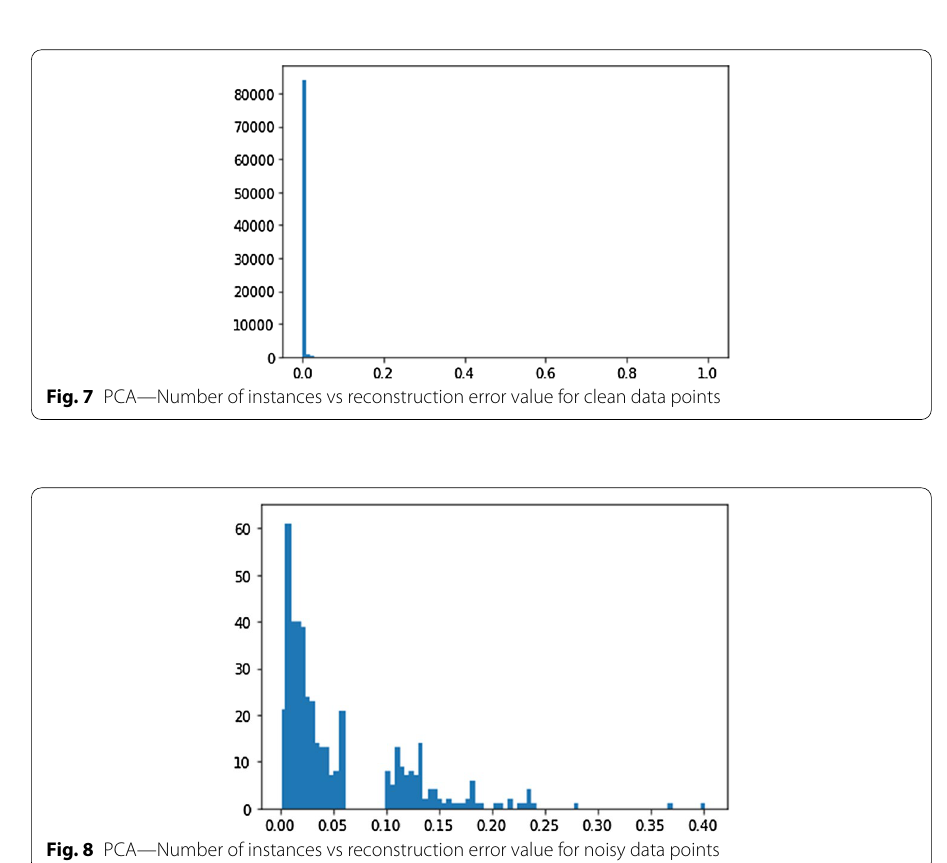
Table 2. Each value is the mean of 40 repetitions (10 runs per experiment x 4-fold cross validation). The best performance score within each column for each algorithm is in italic type.